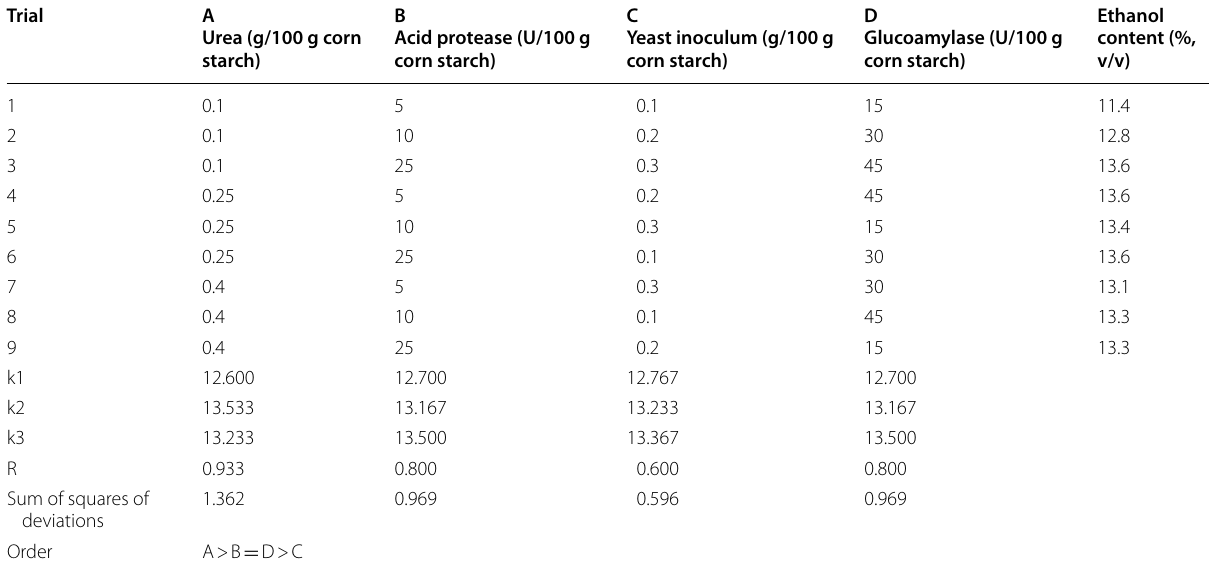
Table 4 Orthogonal test design and results for the production of ethanol using CIBTS1522 under high ratio of raw corn starch to water